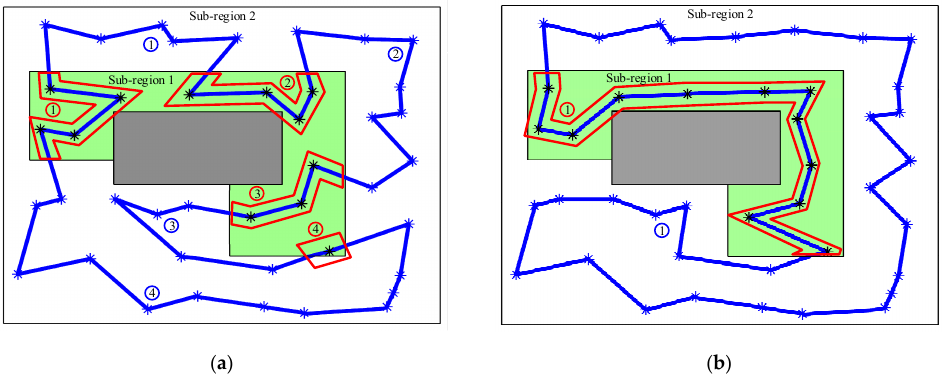
Figure 8. Frame generated based on different distance definitions. Grey rectangles refer to obstacles. Green area indicates sub-region 1. White area is sub-region 2. ( a ) Using Euclidean distance. ( b ) Using distance defined by (14).